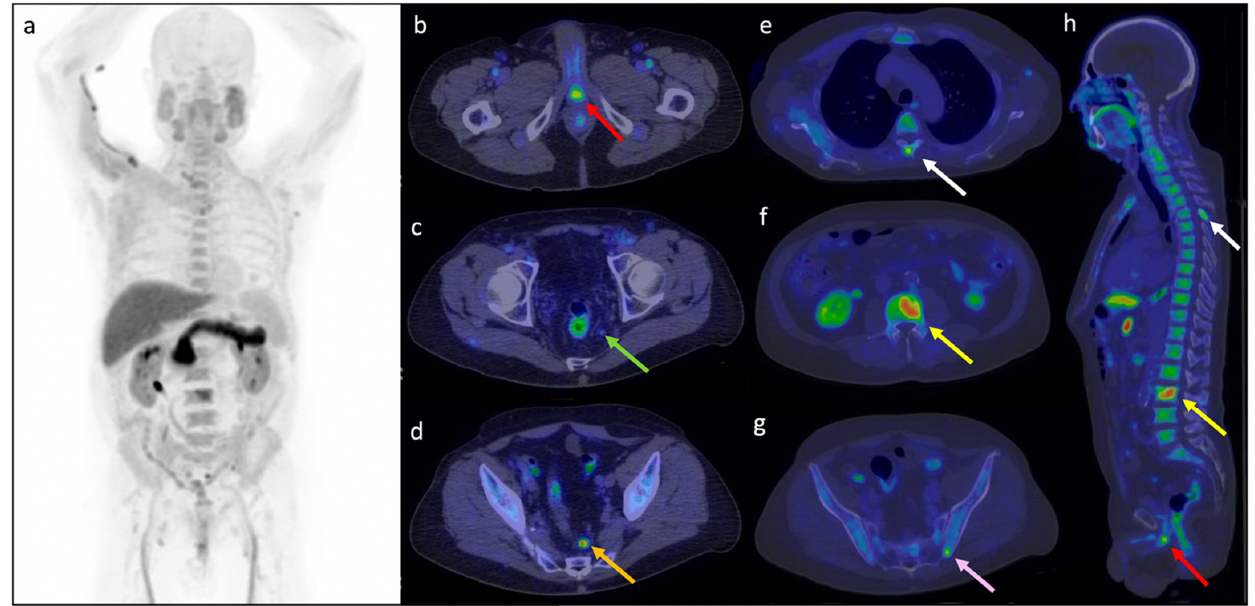
Figure 7. [ 18 F]Fluciclovine PET/CT in a 68 year-old prostate cancer patient in PSA relapse after prostatectomy (2011). Initial staging was pT2aN0R0 and Gleason Score 7 (3+4), classified as high EAU BCR risk group. At the time of the exam, PSA value rose to 0.76 ng/mL with PSA doubling time of 3.4 months. The images (a: Maximum Intensity Projection; b-g: axial fused PET/CT; h: sagittal fused PET/CT) showed increased [ 18 F]Fluciclovine uptake in prostatectomy bed with SUVmax 6.4 and T/Bratio 1.6 (red arrow), in left pararectal lymph node with SUVmax 1.9 and T/Bratio 0.95 (green arrow), in the left presacral lymph node with SUVmax 8.0 and T/Bratio 2.0 (orange arrow), in the spinous process of D4 vertebra with SUVmax of 6.3 and T/Bratio 1.5 (white arrow), in L3 vertebra with SUVmax 9.0 and T/Bratio 2.2 (yellow arrow) and left iliac bone with SUVmax 6.0 and T/Bratio 3.0 (pink arrow).